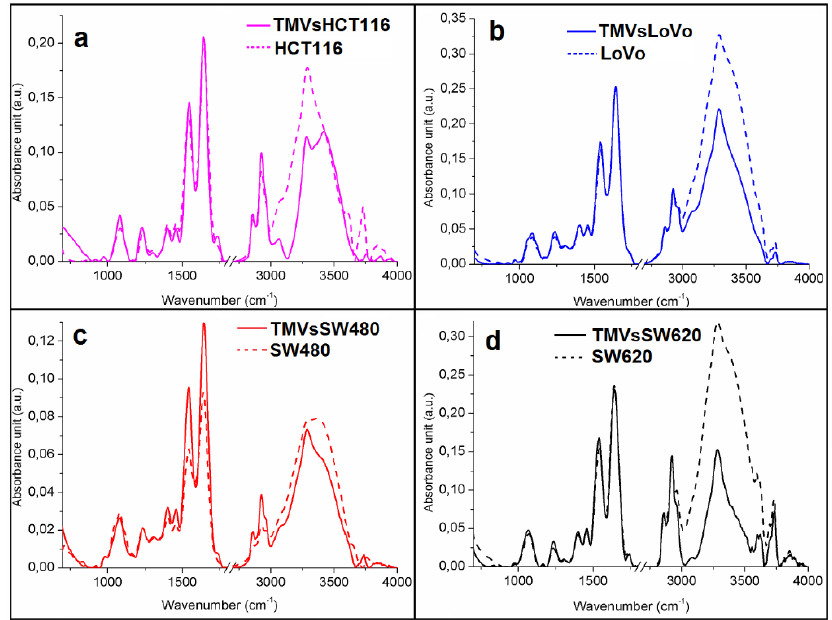
Figure 3. Offset FTIR spectra of: ( a ) HCT116; ( b ) LoVo; ( c ) SW480 and ( d ) SW620 cell lines (dashed lines) and of: ( a ) TMV HCT116 ; ( b ) TMV LoVo ; ( c ) TMV SW480 and ( d ) TMV SW620 (full lines).